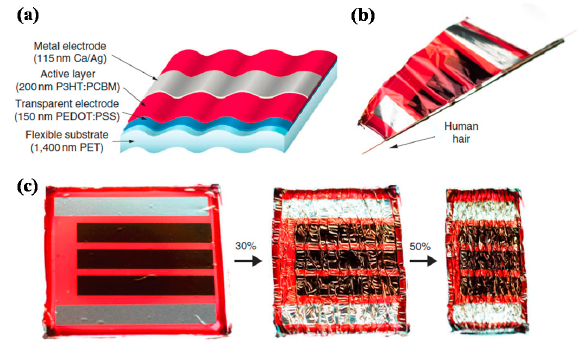
Figure 13. ( a ) Scheme of the ultra-light and flexible organic solar cell; ( b ) Extreme bending flexibility demonstrated by wrapping a solar cell around a 35- μ m-radius human hair; ( c ) Stretchable solar cells made by attaching the ultrathin solar cell to a pre-stretched elastomer. Reproduced with permission from [114]; published by Nature Publishing Group, 2012.